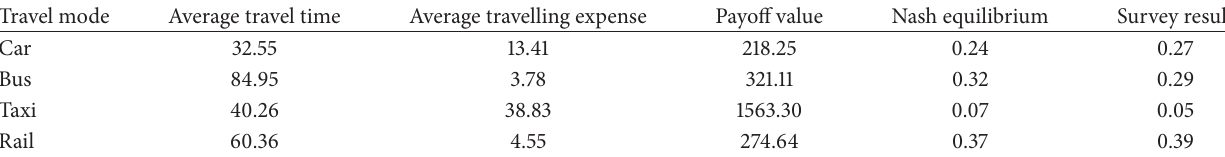
Table 1: Nash equilibrium of travel mode choice game in Beijing.